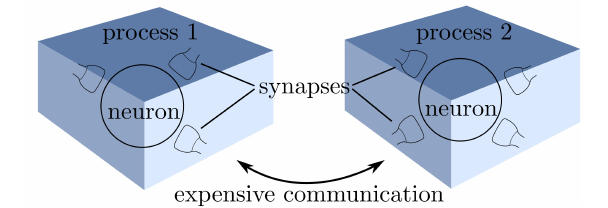
functionals of the postsynaptic spike train s i , the presynaptic spike train s j , and the postsynaptic membrane potential V i